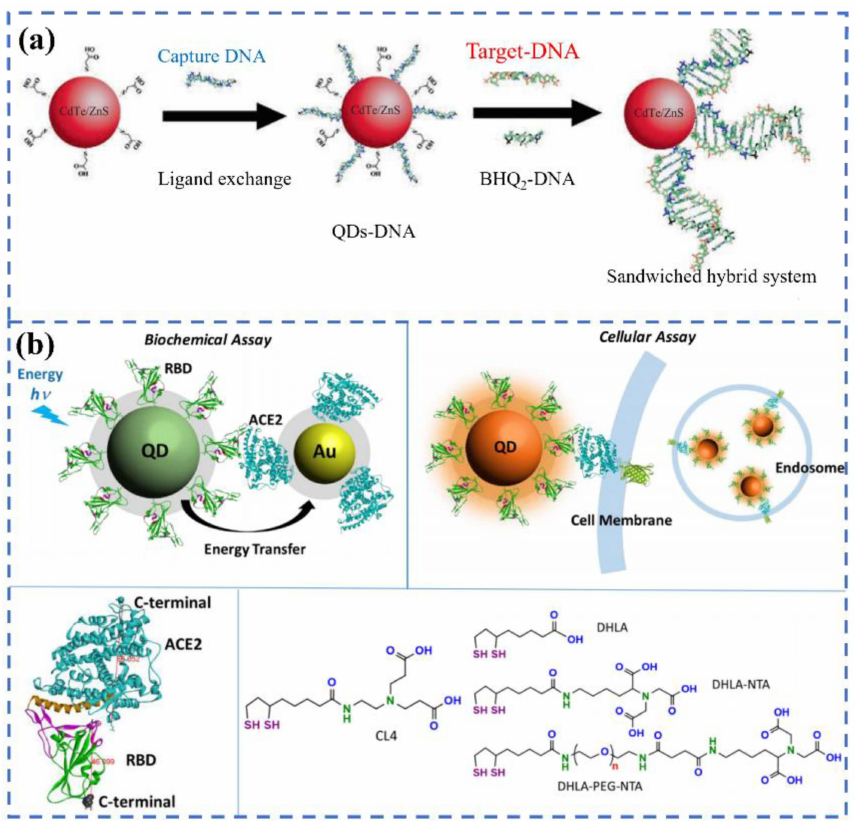
Figure 2. The schematics of the DNA-conjugated CdTe/ZnS QDs nanoprobe for the detection of the target DNA derived from the COVID-19 virus genome( a ). Reprinted with permission from ref. [38]. Copyright 2022, Elsevier. The energy transfer process from QD-RBD to AuNP-ACE2 and the corresponding cellular assay ( b ). Reprinted with permission from ref.